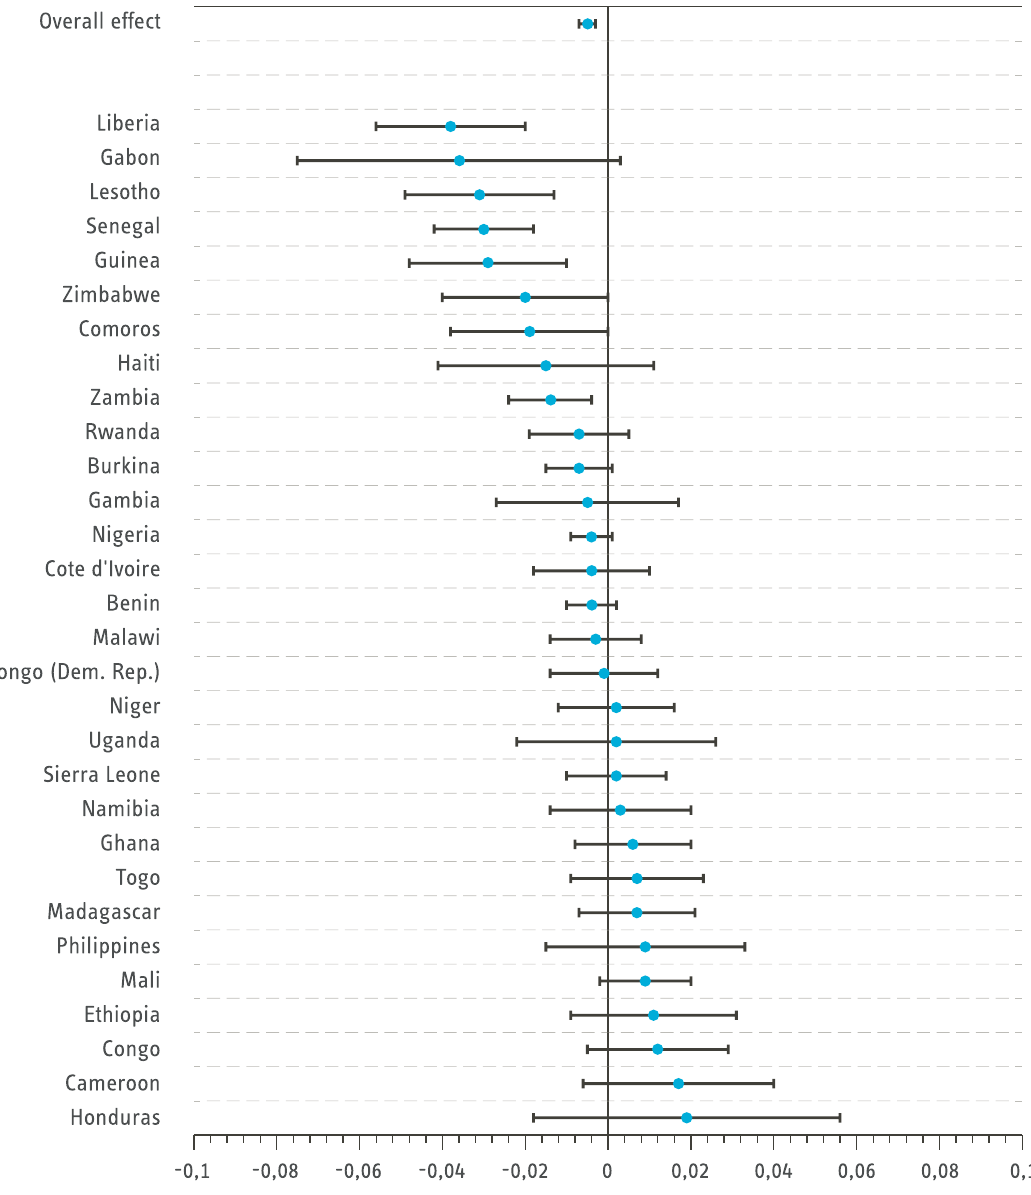
PLOS ONE | https://doi.org/10.1371/journal.pone.0178631 June 28,